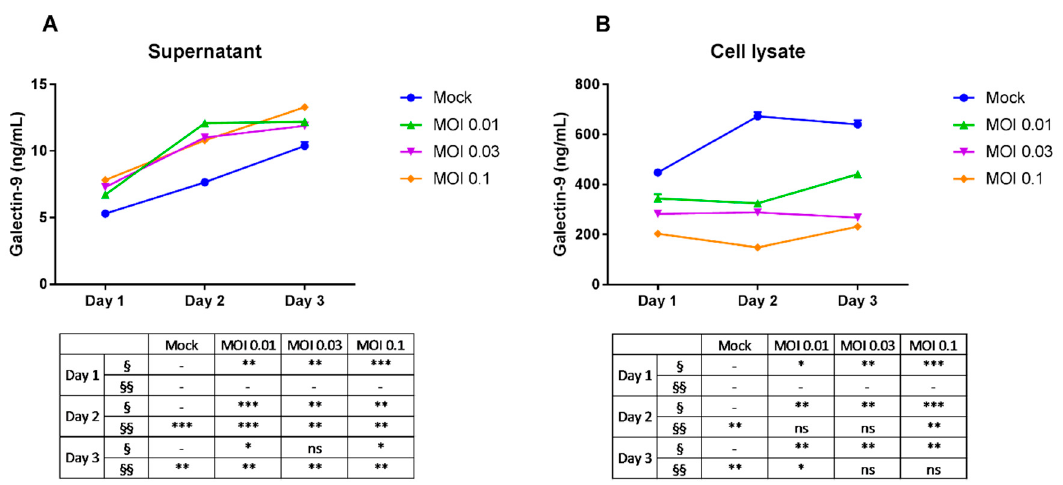
Figure 1. Galectin-9 levels in dengue virus-infected THP-1 cells. Cells were mock-infected or infected with dengue virus-3 (DENV-3) at varying doses. Cells were incubated and harvested after 1, 2 and 3 days post-infection. Extracellular ( A ) and intracellular ( B ) galectin-9 was assayed using ELISA. Unpaired t -test was used to calculate significance (ns = no significance, * p ≤ 0.05, ** p ≤ 0.01, *** p ≤ 0.001) vs. control. Data represent mean ± SEM (standard error of the mean) of representative data of three experiments with similar results. § and §§ represent dose- and time-dependent variables, respectively. MOI: multiplicity of infection.